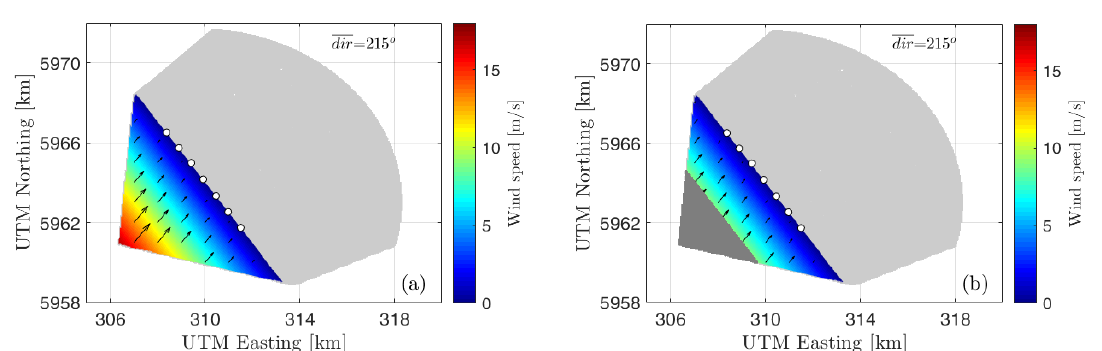
Figure 12. Wind speeds to be forecasted at the wind turbines (white dots) for a horizon of five minutes, a south-southwesterly wind direction and the radar available distance for ( a ) full radar availability; ( b ) limited radar availability.